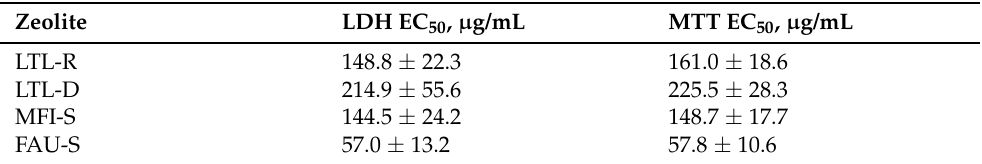
Table 2. Calculated EC 50 values represent effective concentration of zeolites that increases LDH leakage to 50% or decreases MTT reduction by 50%